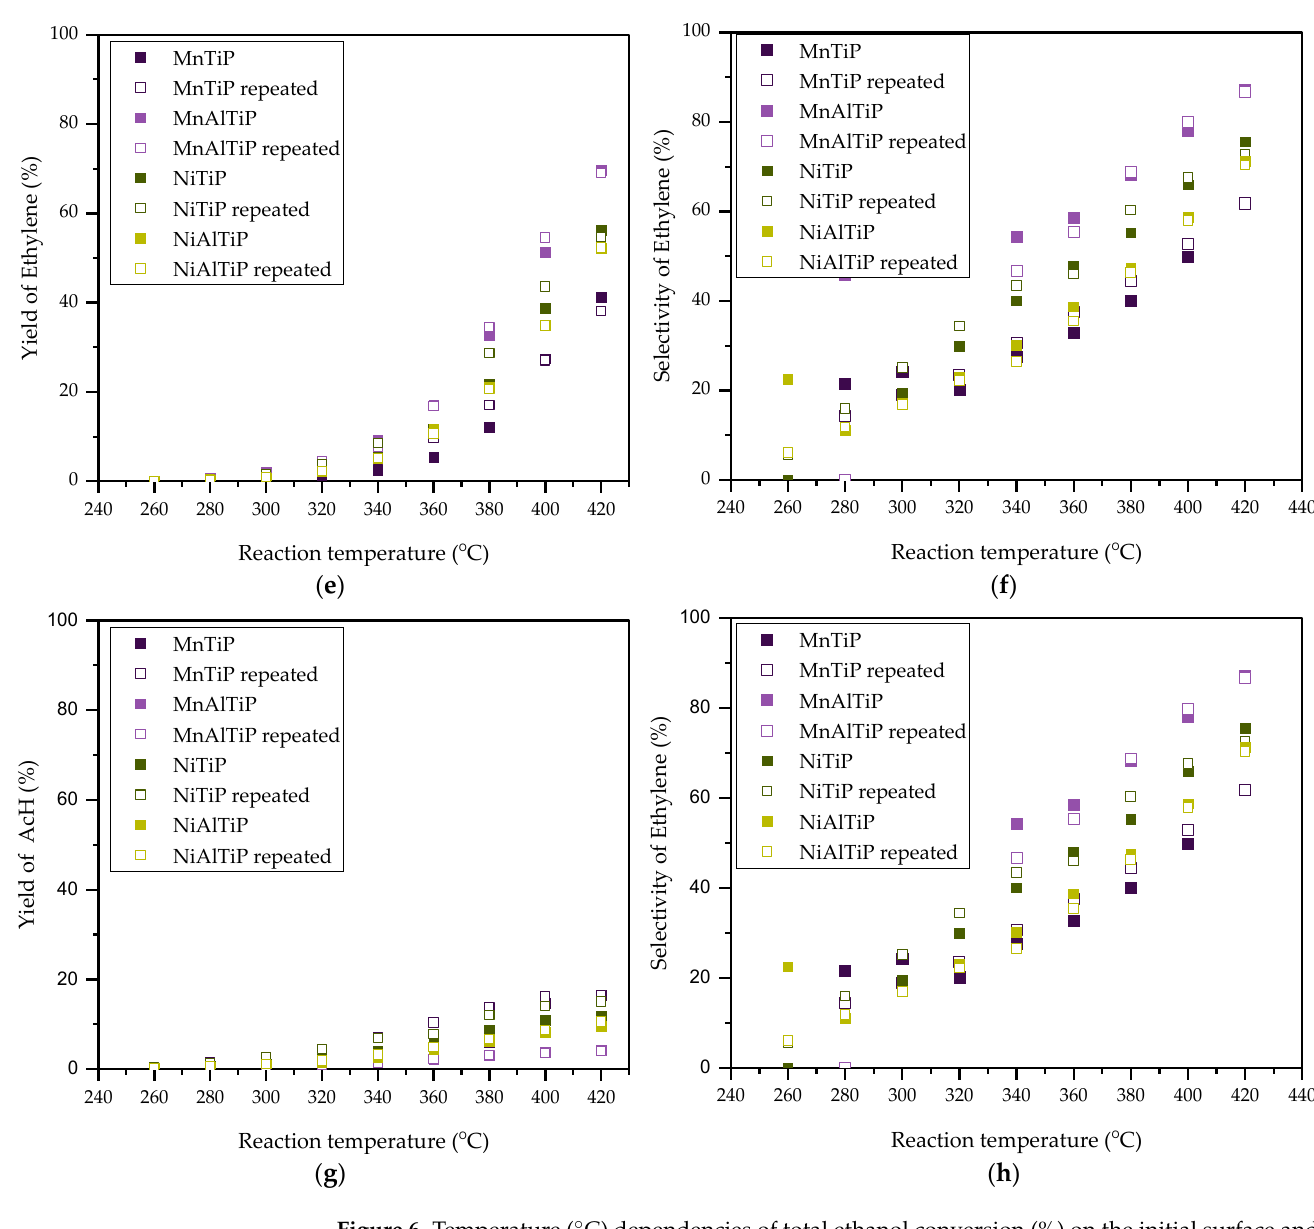
Figure 6. Temperature (°C) dependencies of total ethanol conversion (%) on the initial surface and for repeated test ( a , b ); Temperature dependencies of the yield and selectivity of diethyl ether ( c , d ), ethylene ( e , f ) and acetaldehyde ( g , h ). Open squares are used for the repeated experiment. Table 4. Performance of various catalysts for ethanol dehydration to ethylene at 400 ◦ C. Composition of the Catalysis Selectivity to Ethylene (%) Ethylene Yield (%) Reference NiAlTiP This